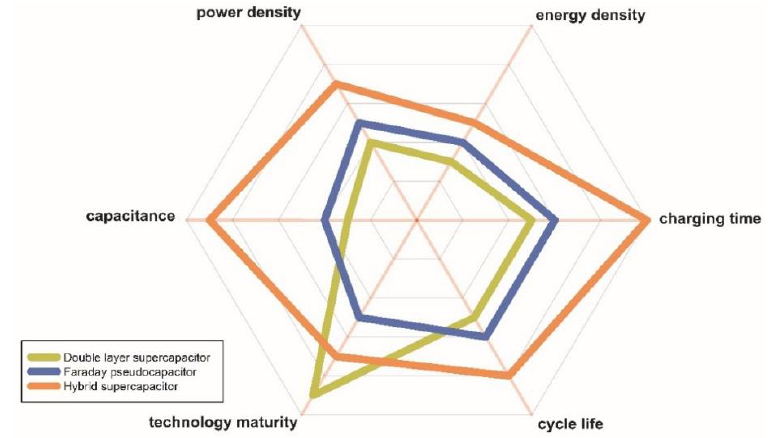
Figure 3. Different characteristics among three types of supercapacitors.